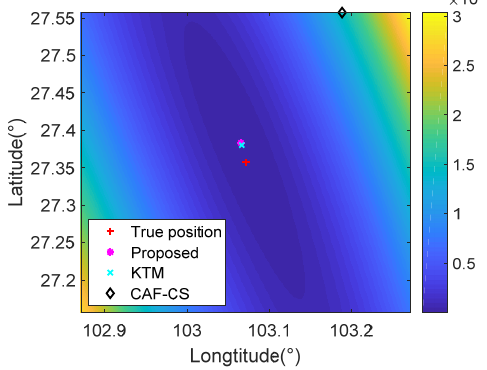
Figure 17. Locating results.